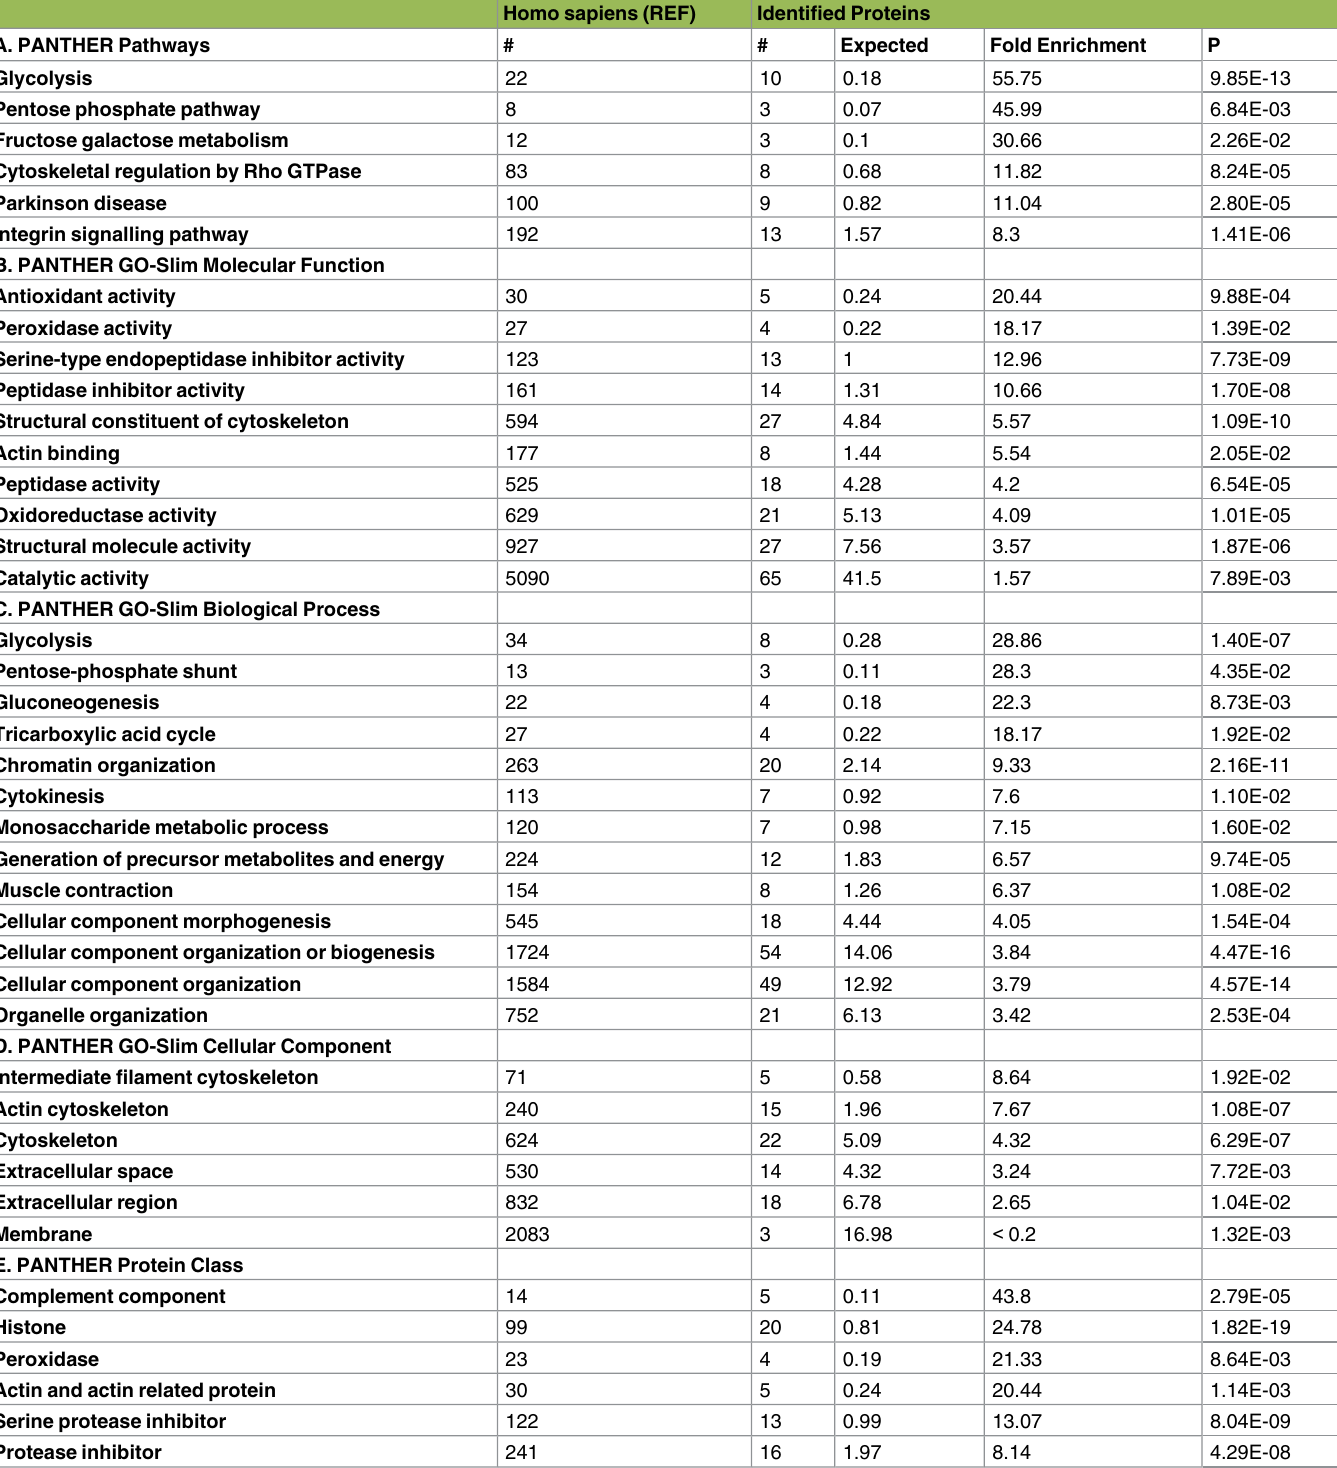
Table 3. PANTHER Overrepresentation test (release20160715)with annotation version 11.1. Classification of identifiedproteins basedon A) Path- ways, B) MolecularFunction, C) Biological Process, D) CellularComponent and E) Protein Class. Homo sapiens